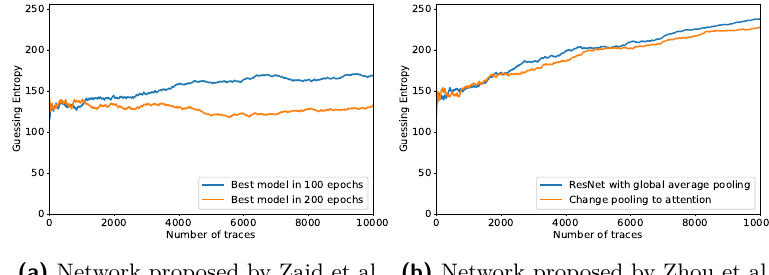
Figure 16: Guessing entropy of two state-of-the-art CNNs applied to raw traces.